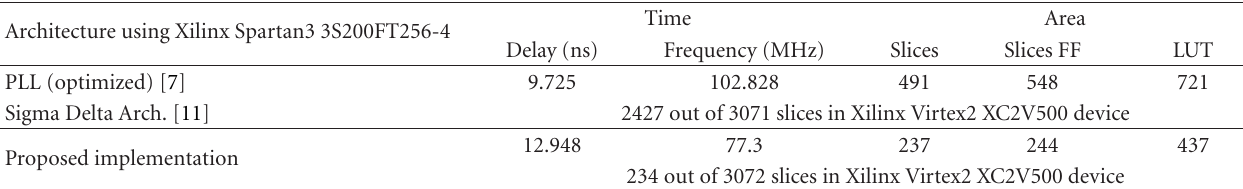
Table 6: FPGA resource usage comparison result with other FM demodulators.